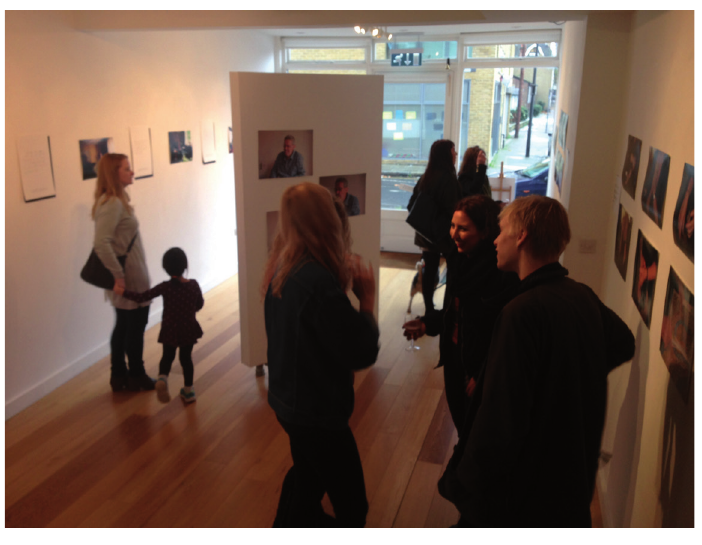
Figure 6: The exhibition open event at the Paul McPherson Gallery, Greenwich, November